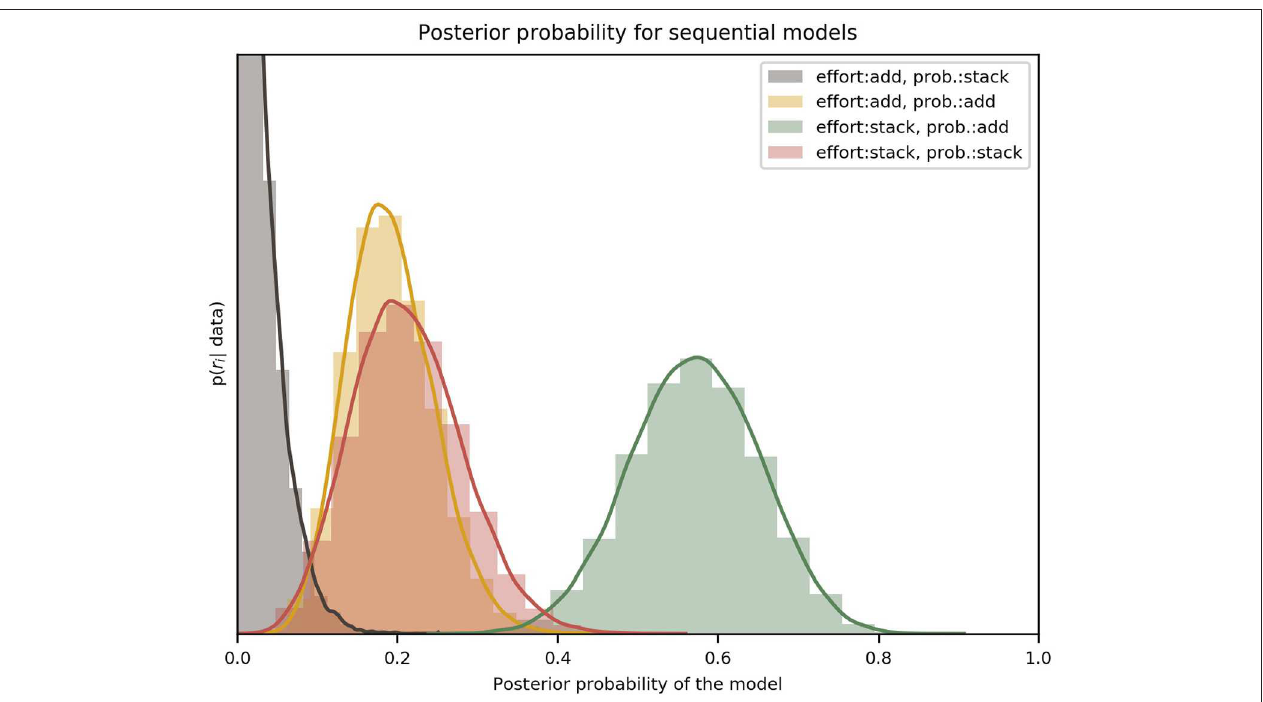
FIGURE 4 | Comparison of the four variants of the forward-planning strategy. The label effort: add/probability: stack, for example, refers to the forward-planning strategy where effort is added and probability stacked. Each of the four distributions, indicated by a solid curve and a histogram, represents the estimated posterior probability of a specific model. It can be clearly seen that the best model for all participants was the “effort: stack/probability: add” variant. The colored lines are an interpolation with a Gaussian kernel. The two effort discount functions (hyperbolic and sigmoid) have been marginalized to compare only the forward-planning components. The y-axis is the probability density of r i given the data [ p ( r i | data) in Equation 14]; the x-axis spans all the possible values of r . The peak of the red (add/stack) curve is not shown because the vertical range was cut short for visual